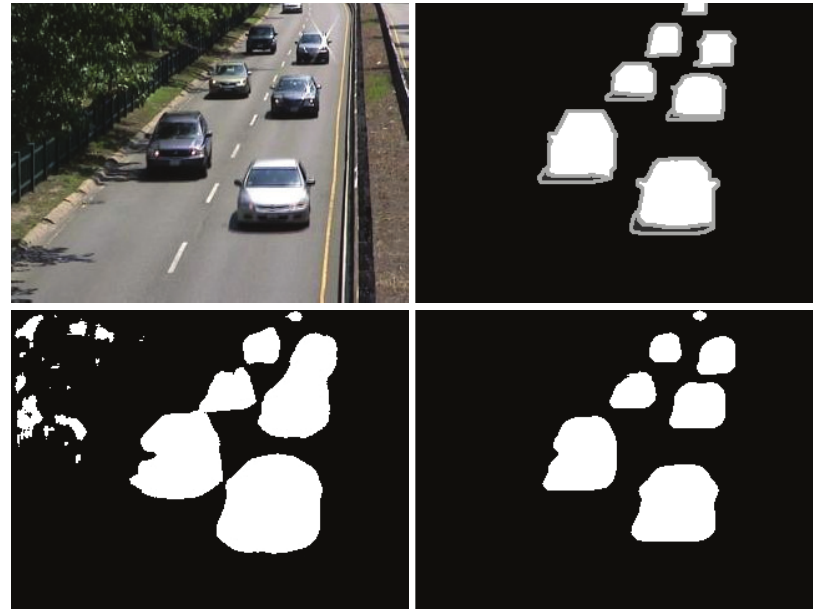
Figure 2. Foreground detection results with IIF and Local Similarity Statistical Descriptor (LSSD) on the sequences of highway. First row: input image and the corresponding ground-truth. Second row: foreground detection results with the original illumination invariant feature image and the segmentation results of the proposed